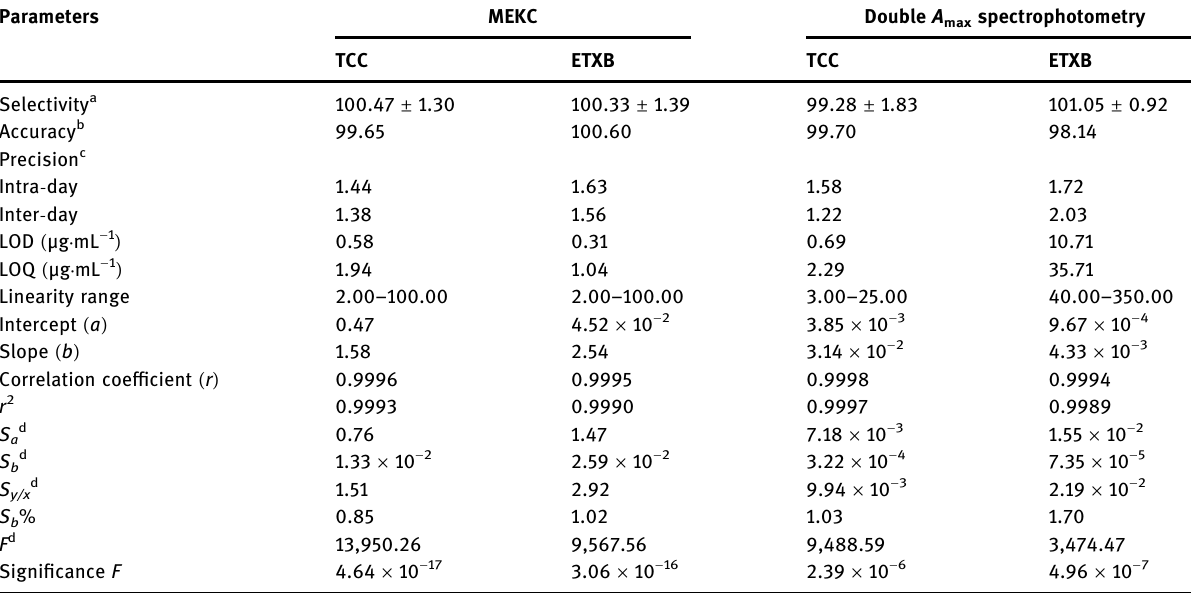
Table 1: Validation and regression parameters of the proposed methods